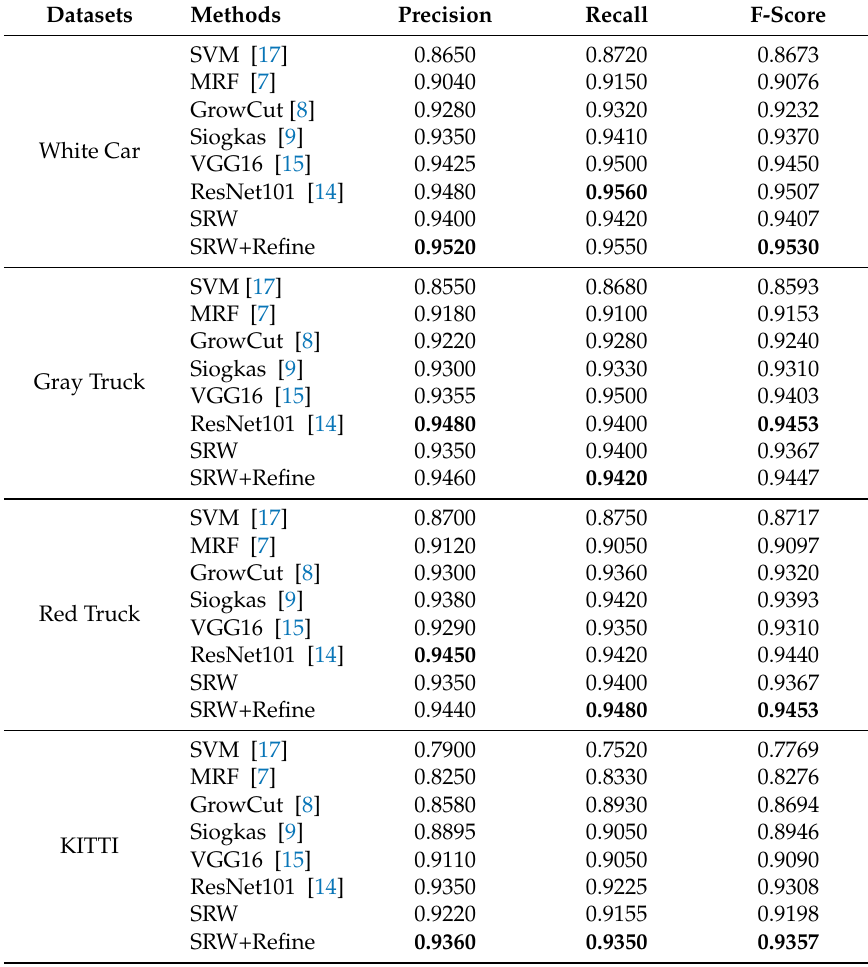
Table 4. Evaluation of road detection